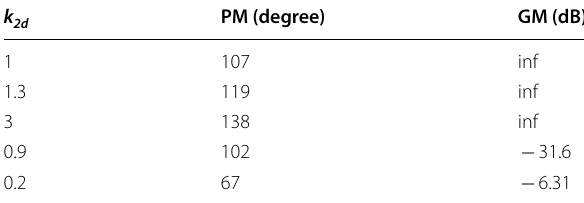
Table 7 GM and PM of the RSC control circuit using FFOADRC (for k 1, α 0.7, ω 10, and different k 1d = c = =